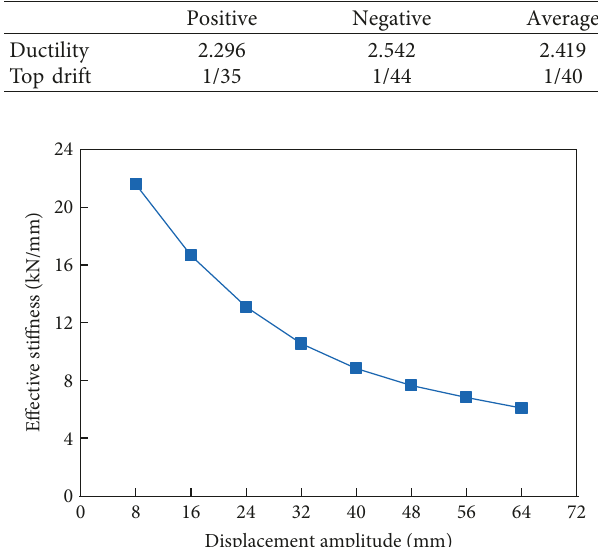
Figure 12: Effective stiffness vs. displacement amplitude